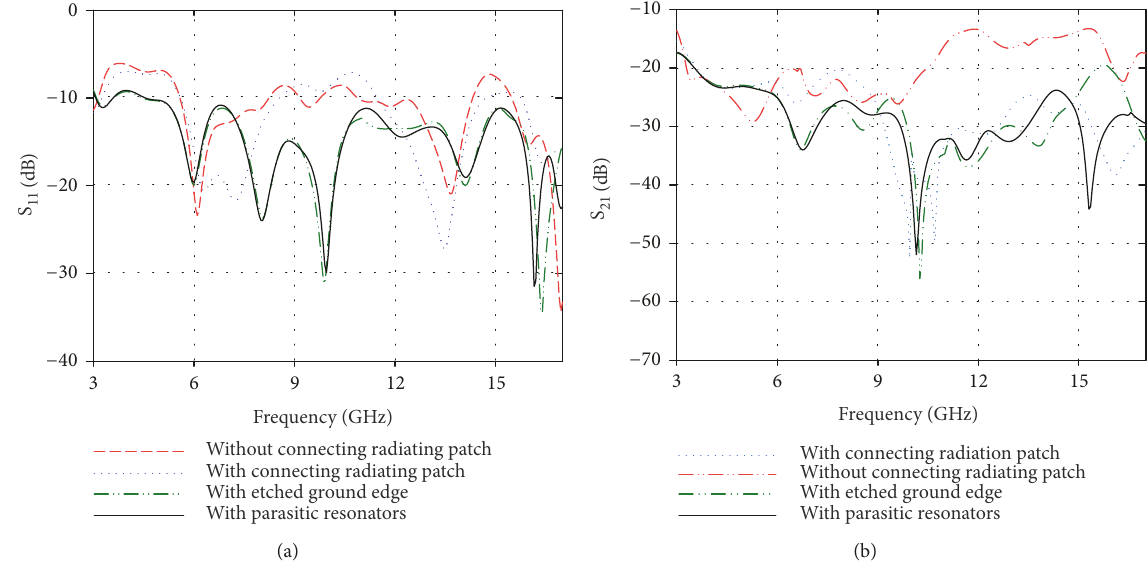
Figure 3: Simulated S-parameters to illustrate different stages of antenna variation in design for improving the antenna bandwidth and reducing the mutual coupling (a) Simulated reflection coefficient S 11 (dB), (b) simulated coupling coefficient S 21 (dB).